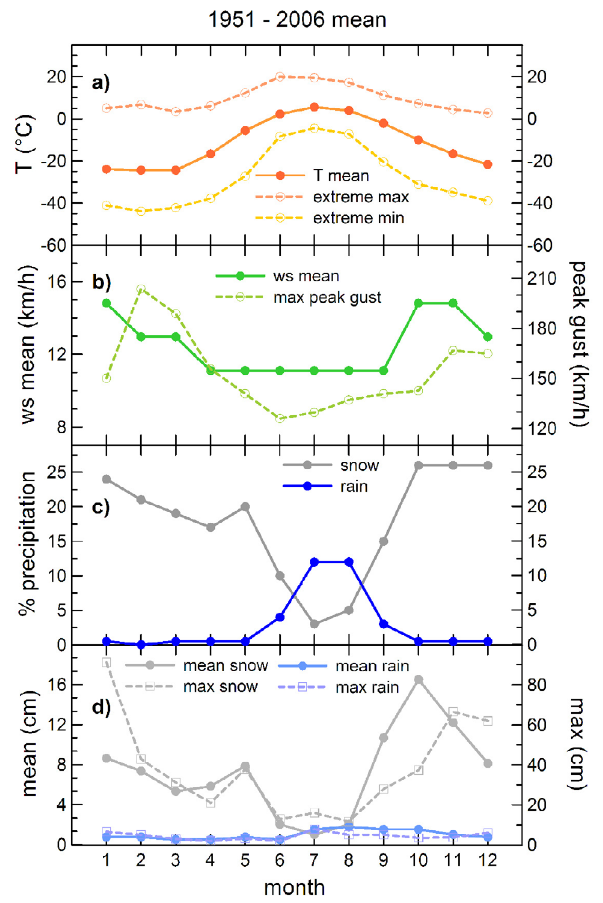
Figure 7. 1951 to 2006 monthly mean of: (a) surface temperature, T, and its maximum and minimum extremes; (b) surface wind speed (ws) and maximum gust speed; (c) fractional amount (in per- cent) of precipitations as rain and snow; (d) mean and maximum rainfall and